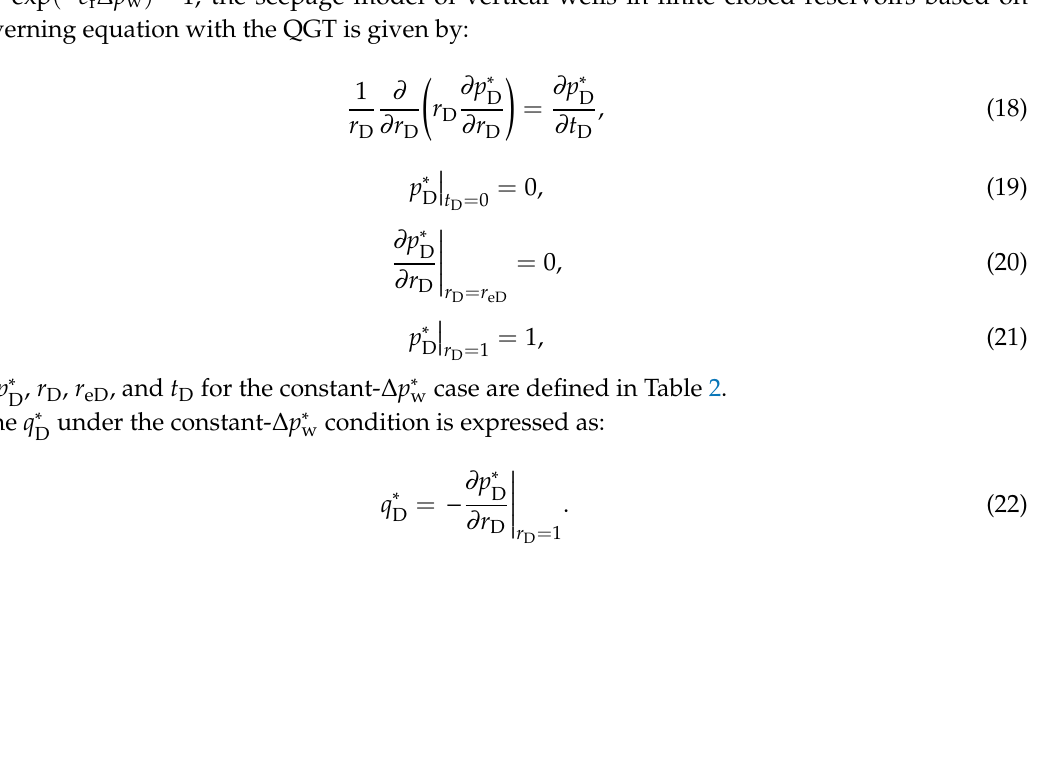
1 p vs. t ” curve for the CRP case and the “ wD cD